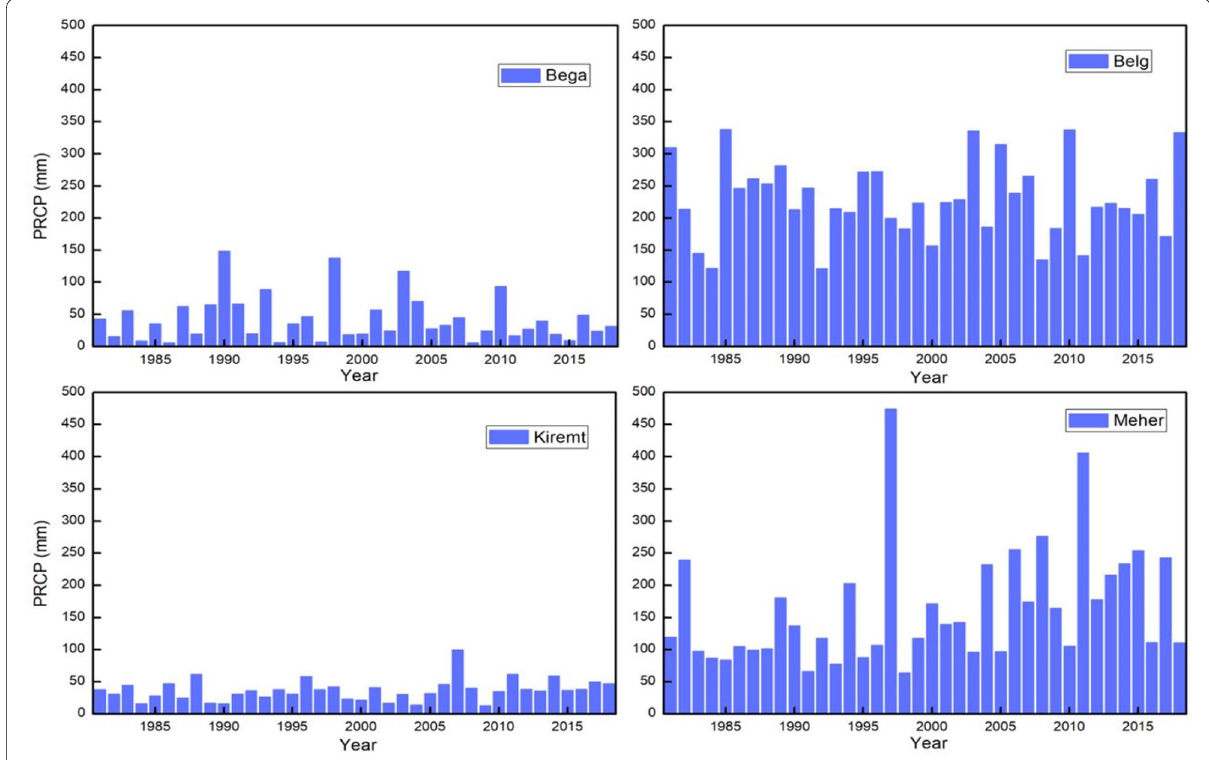
Fig. 5 Seasonal precipitation distribution in semi-arid Borana